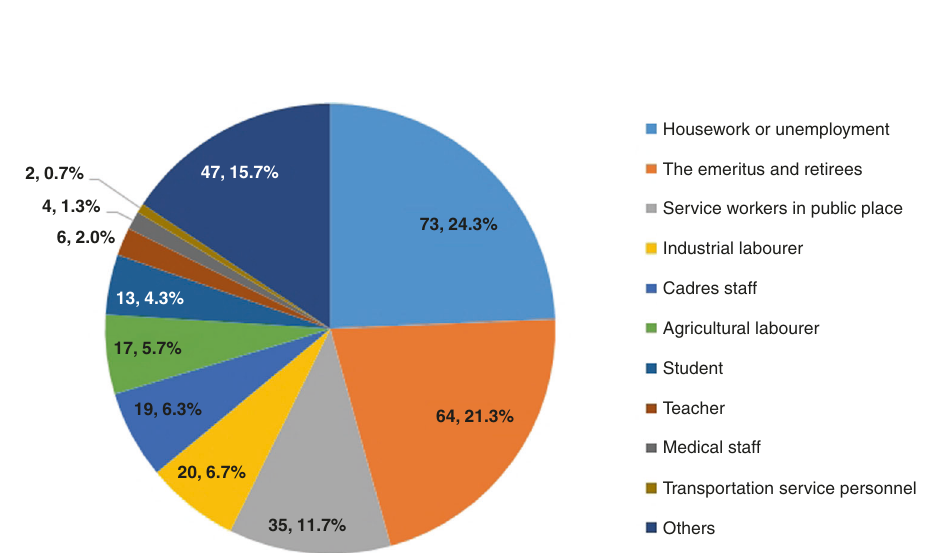
Fig. 1 The occupation distribution of asymptomatic positive cases (%). Note: Others included the self-employed, military personnel, and so on. (Source data are provided as s Source Data fi